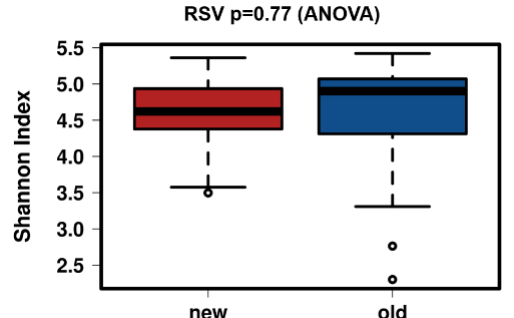
Figure 2. Alpha diversity boxplots using the Shannon diversity index showing the new benchmark of diversity found in this study (red) and comparing it with the results from our previous work (blue). There are no significant changes in alpha diversity between the studies. The black lines indicate average diversity. Samples were rarefied to 6600 sequence reads.